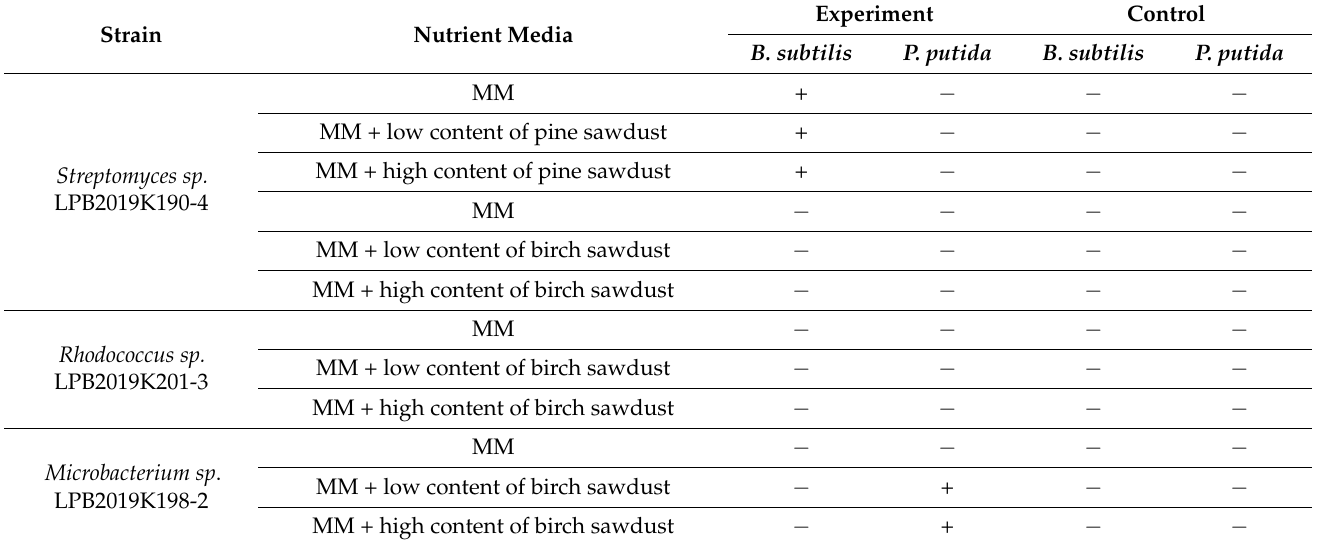
Table 2. Antibacterial activity of studied strains cultivated on gradient nutrient media with sawdust waste. Strain Nutrient